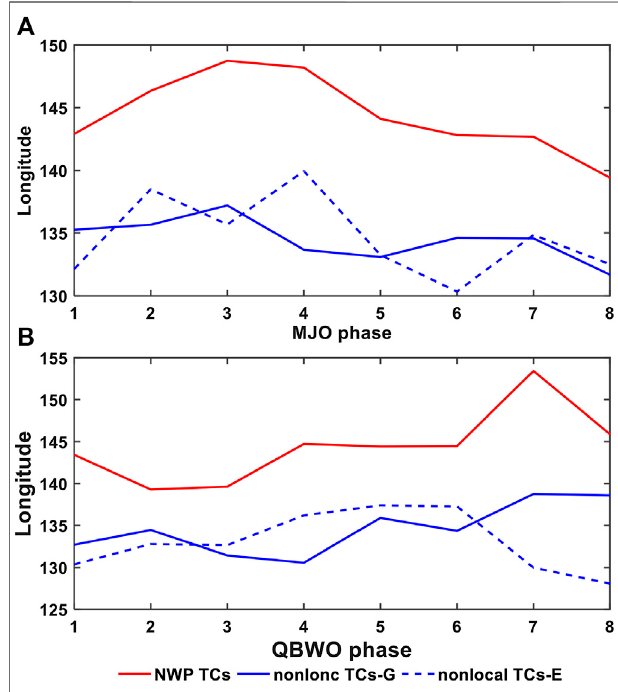
FIGURE4| Themeangenesis longitudefortotalNWPTCs(redline)and nonlocal TCs (blue lines) in each phase of MJO (A) , and QBWO (B) . The nonlocalTCs-GandnonlocalTCs-Edenotethephasescompositedbasedon the genesis day and the day that the nonlocal TCs entered the SCS,